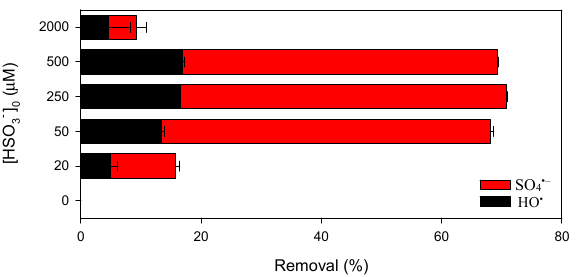
Figure 1. Influence of the dosage of HSO 3 − on the removal of CBZ by Mn(III) at pH 7.0. Conditions: [CBZ] 0 = 5 µM, [NB] 0 = 1 µM, [Mn(III)] 0 = 50 µM, [PP] 0 = 2.5 mM, reaction time = 20 s.